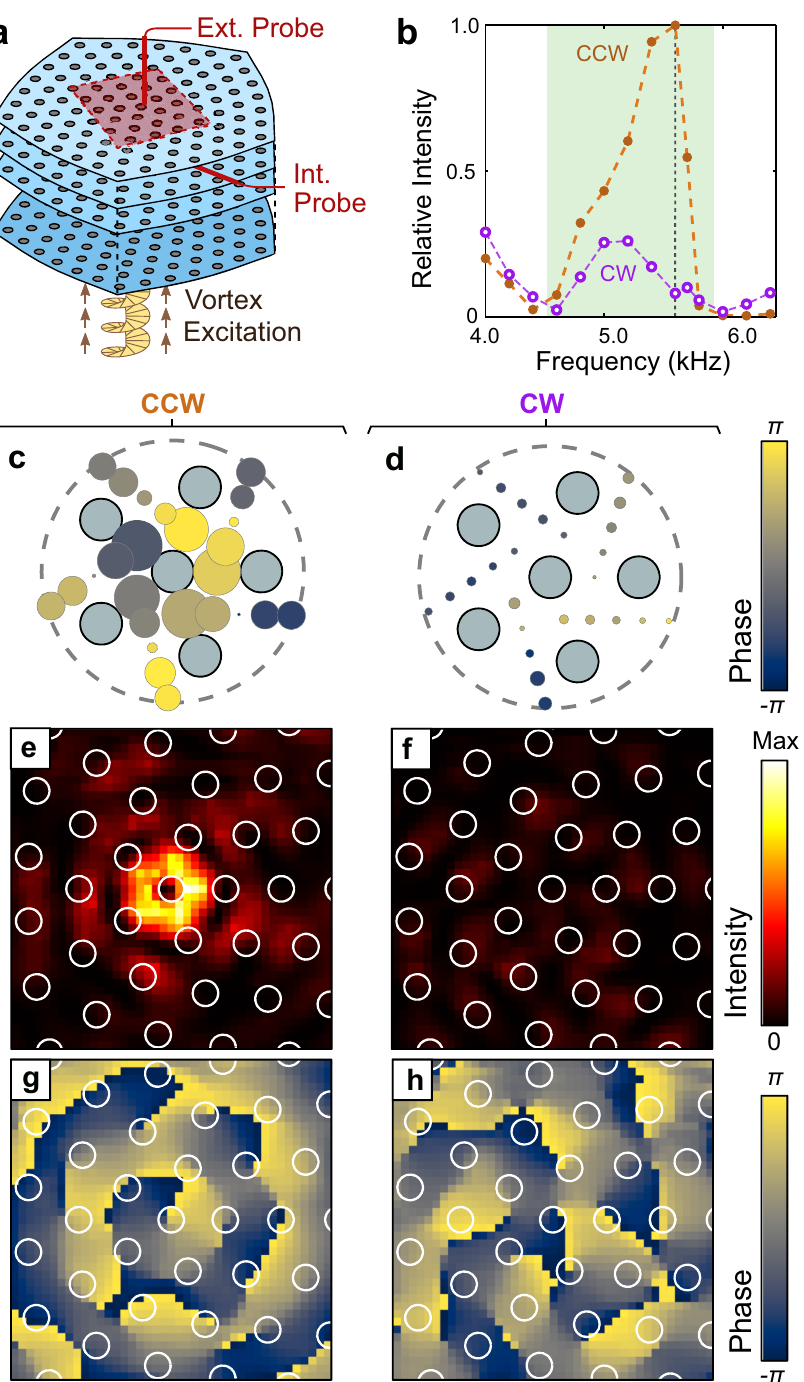
Fig. 4 Selective excitation by a vortex source. a Schematic of the experiment. A counterclockwise (CCW) or clockwise (CW) acoustic vortex is incident on the bottom of the sample, centered on the TLD. An external probe, 2 mm above the top surface, sweeps over a 20 cm × 20 cm area (0.5 cm step size). An internal probe is inserted into the top layer. b Normalised acoustic pressure intensity versus frequency measured in the top layer by the internal probe for a CCW (purple dots) and CW (orange dots) vortex source. The green region indicates the frequency range hosting TLD-bound modes. c , d Acoustic pressure distribution in the top layer for a CCW ( g ) and CW ( h ) vortex source at 5.6 kHz (vertical dotted line in b ). The area and colour of each circle correspond to intensity and phase respectively. e , h Intensity distributions ( e , f ) and phase distributions ( g , h ) measured by the external probe for a CCW ( c ) and CW ( d ) vortex source. The grey circles in ( c – d ) and white circles in ( e – h ) indicate the structural